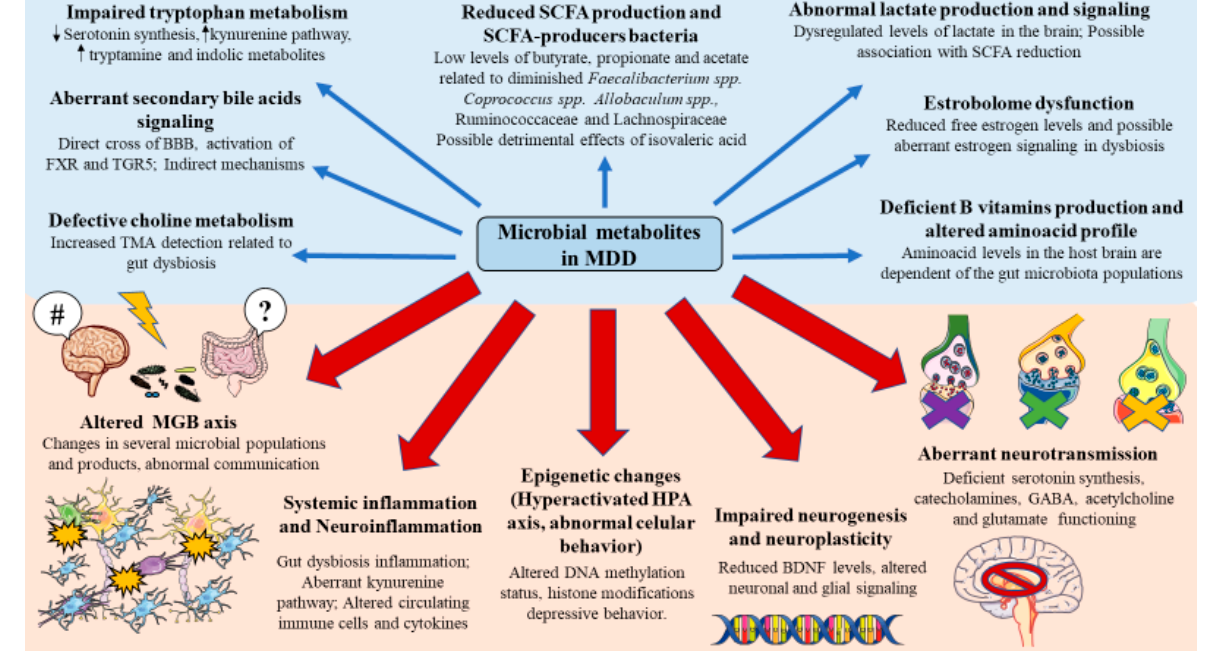
Figure 2. Dysregulation of microbial metabolites in MDD and its consequences. As summarized, a noteworthy dysregulation of SCFAs, lactate, secondary bile acids, choline metabolites, vitamins, amino acids, estrogen, and tryptophan metabolites are potentially involved in the pathogenesis of MDD. Some of the mechanisms reviewed in this article included an altered MGB axis, systemic and local neuroinflammation, epigenetic changes affecting multiple brain regions, impaired neurogenesis and neuroplasticity as well as leading to aberrant neurotransmission.